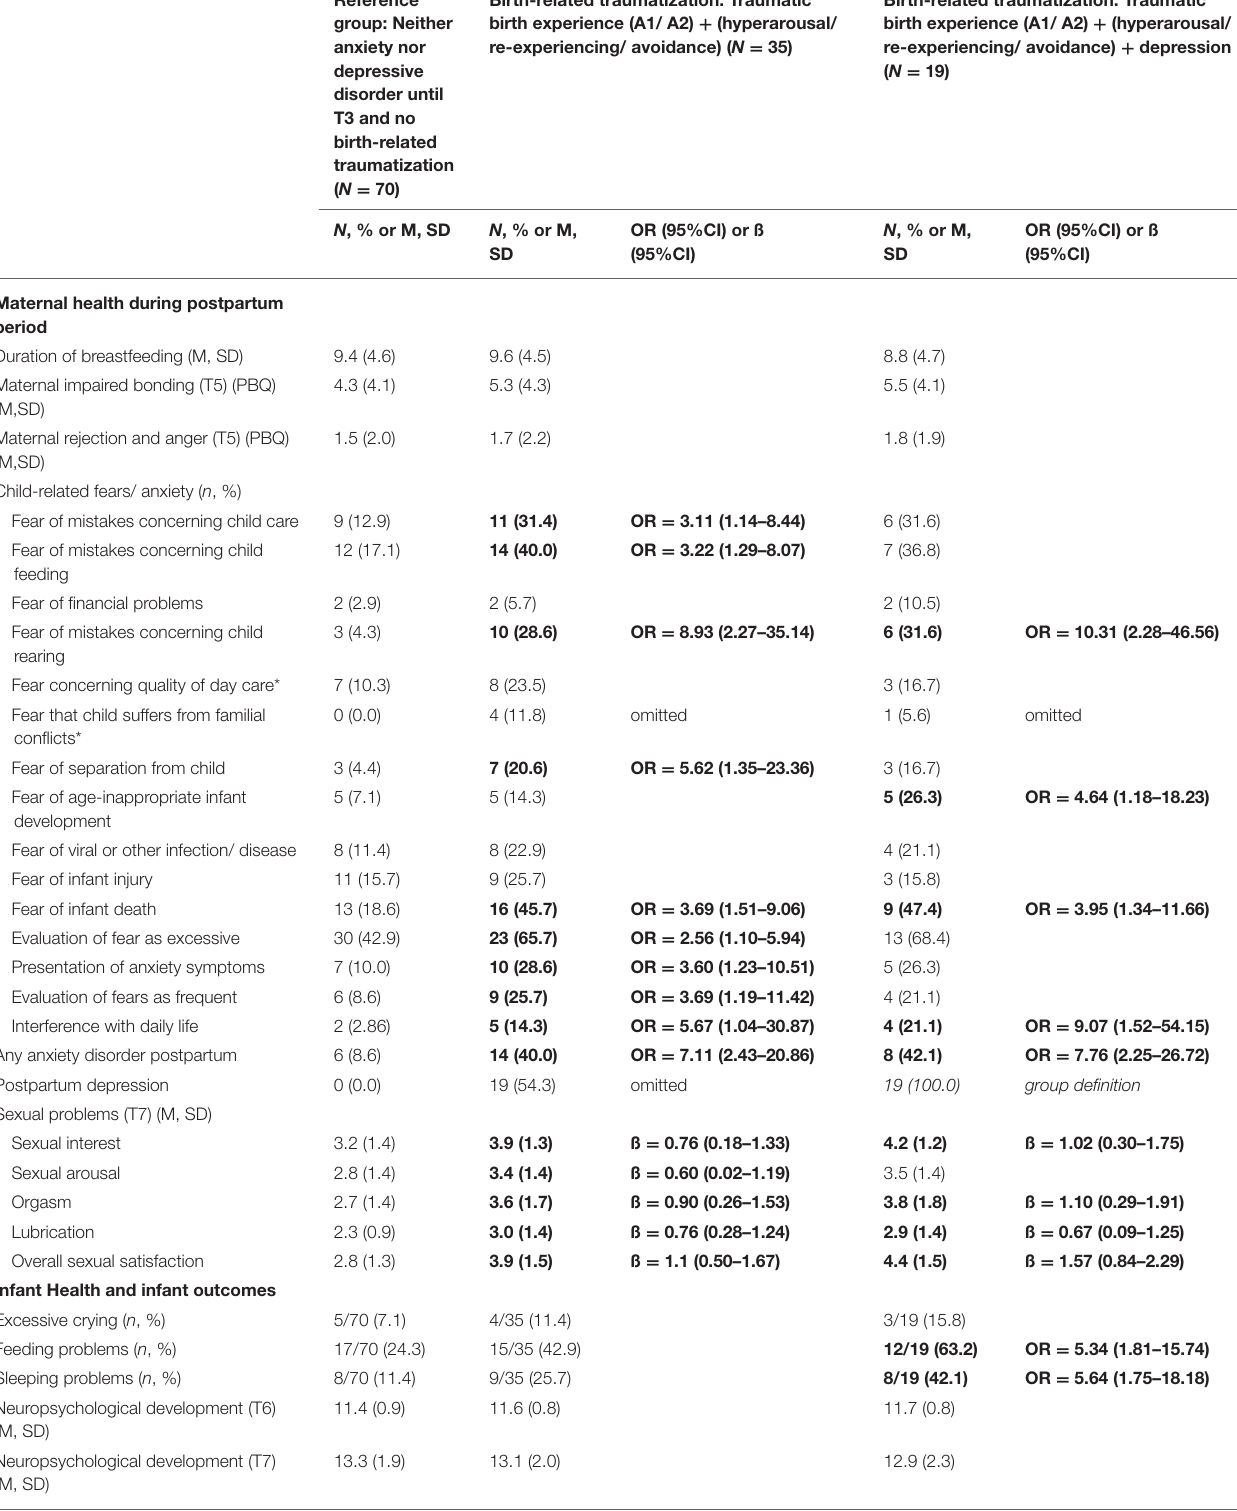
TABLE 3 | Maternal and infant outcomes in women with birth-related traumatization (and depression) after delivery compared to women with neither anxiety nor depressive disorder until T3 and no birth-related traumatization. Reference group: